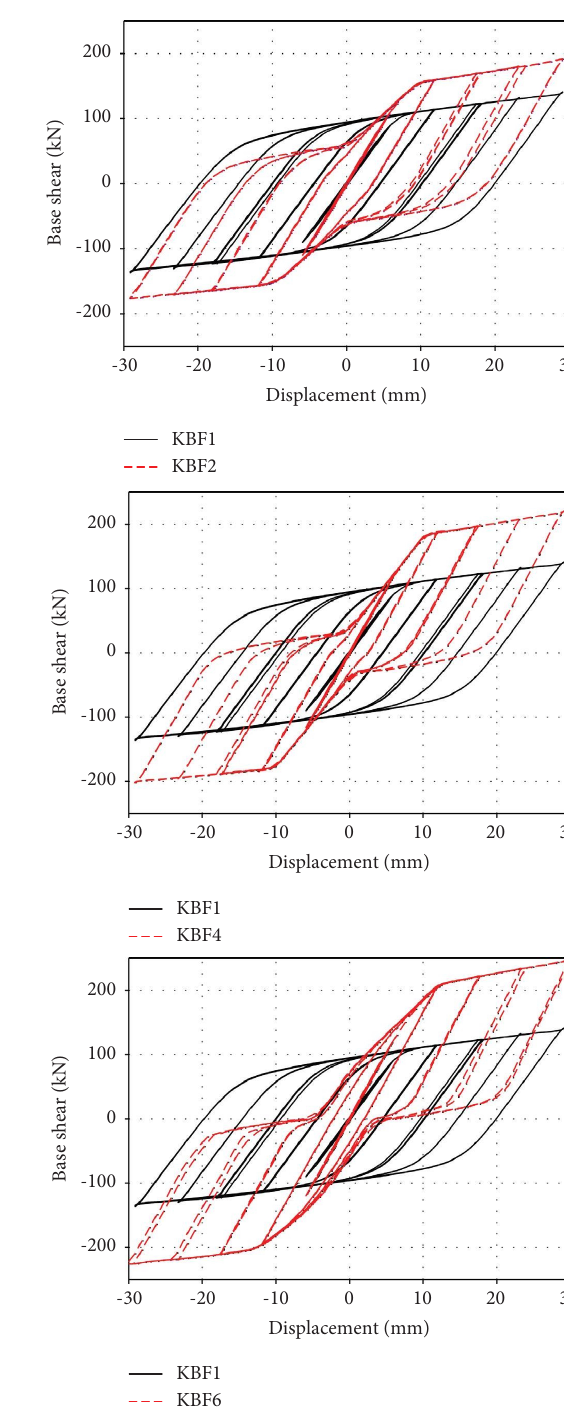
Figure 16: Hysteresis diagrams of the numerical